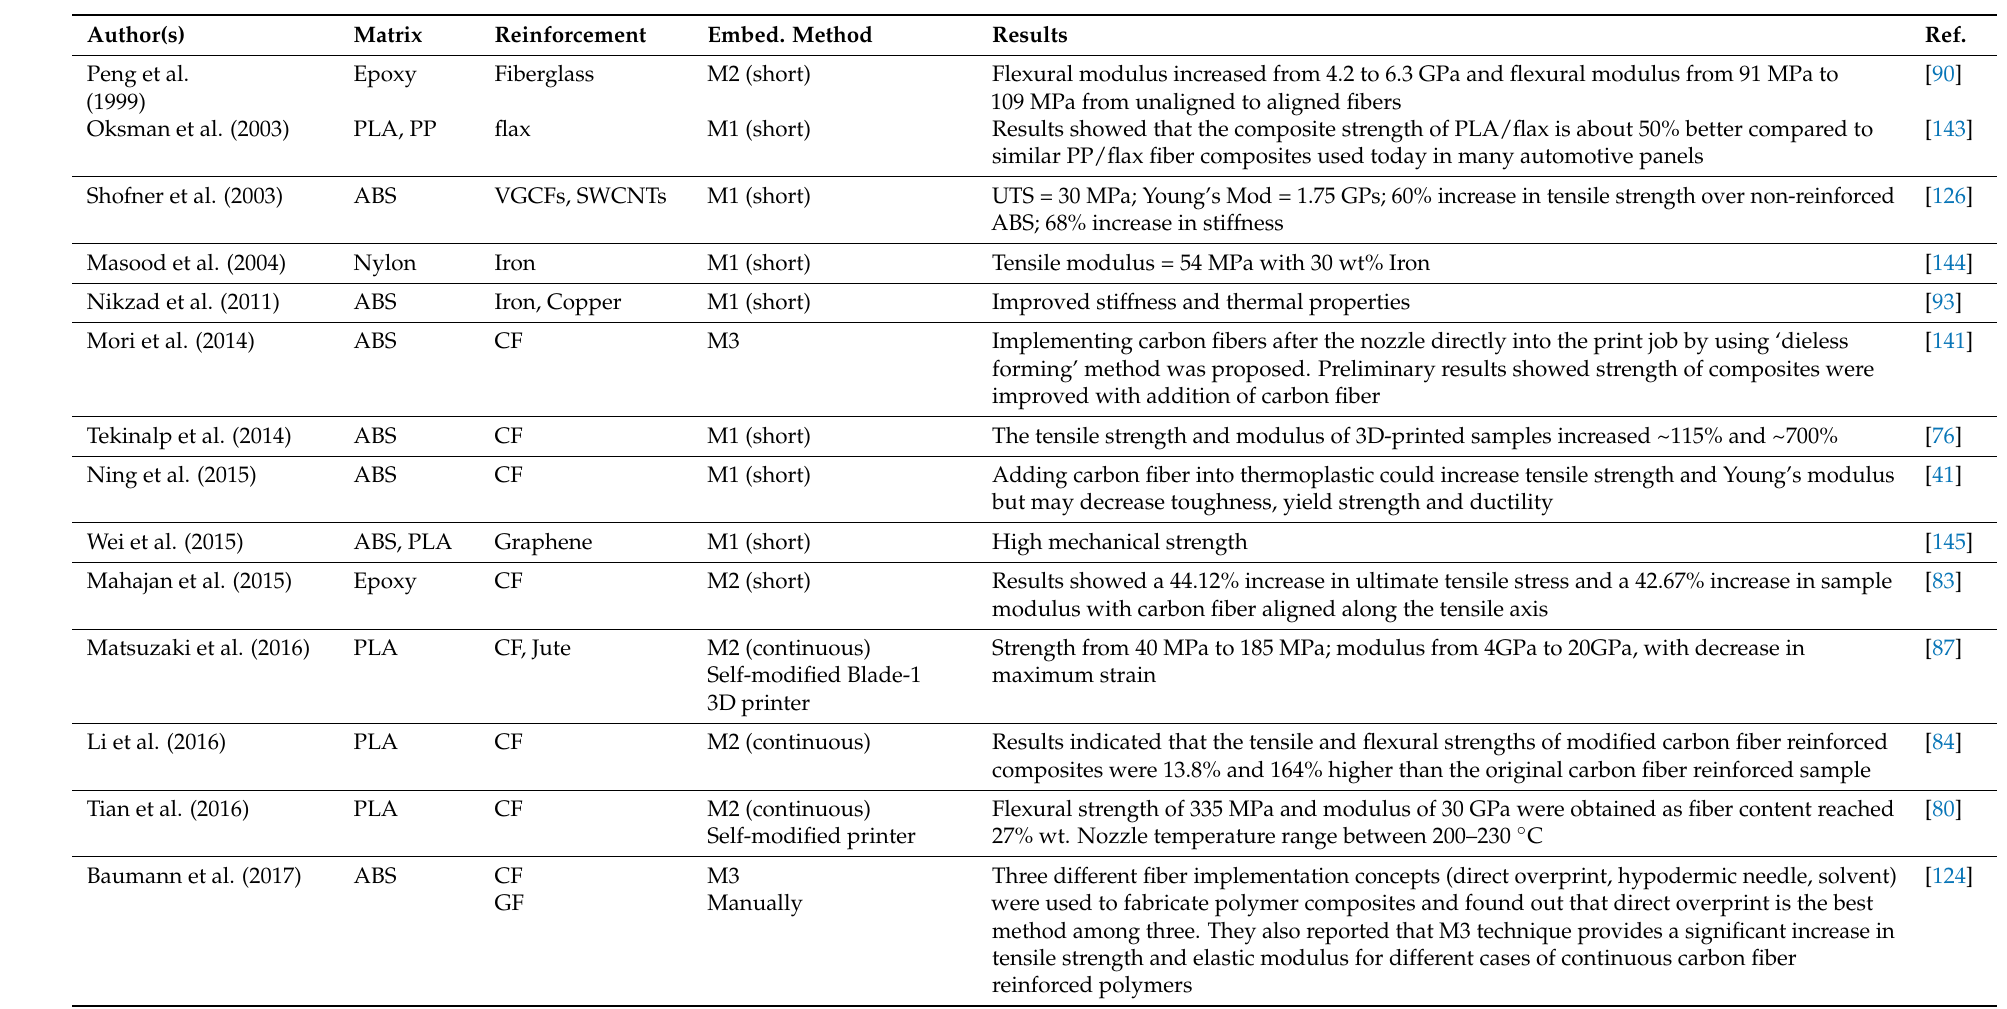
Table 6. Selected research of fiber reinforced polymer in FDM by different embedding